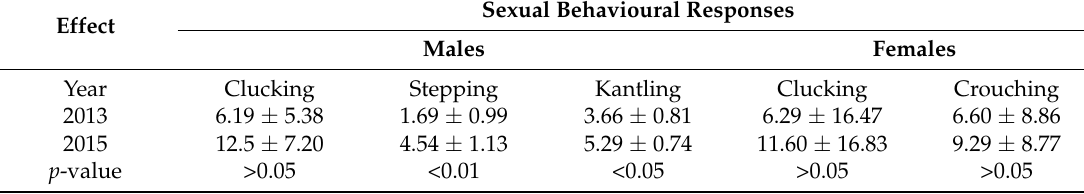
Table 2. Predicted least square mean estimates ( ± SE; derived from back transformation the logit function) from reactivity tests for sexual behavioural responses of ostriches relative to the year of observation ( N = 207).